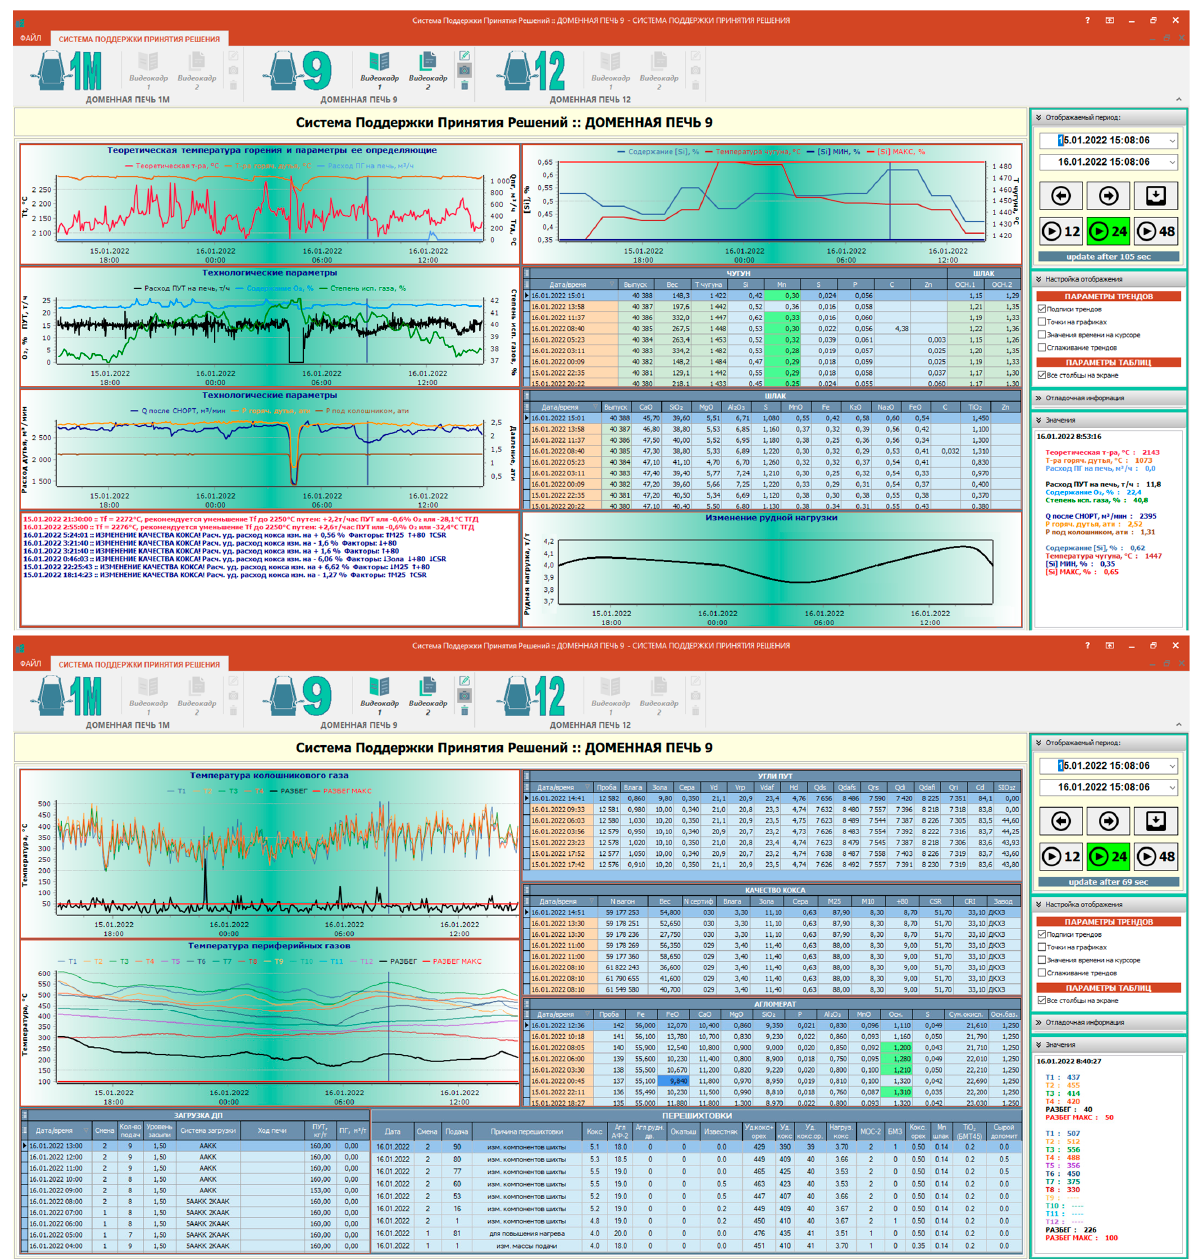
Figure 1. Screenshots of the DSS software for stabilizing the thermal state of the BF. In addition, the DSS generates recommendations for certain technology deviations, namely, when changing the quality of coke and pulverized coal, in the case of deviations from the basic range of changes in the RAFT and the parameters that determine it, when the ore load changes incorrectly, etc. In the case of incorrect actions by the personnel, the system signals the need for corrective